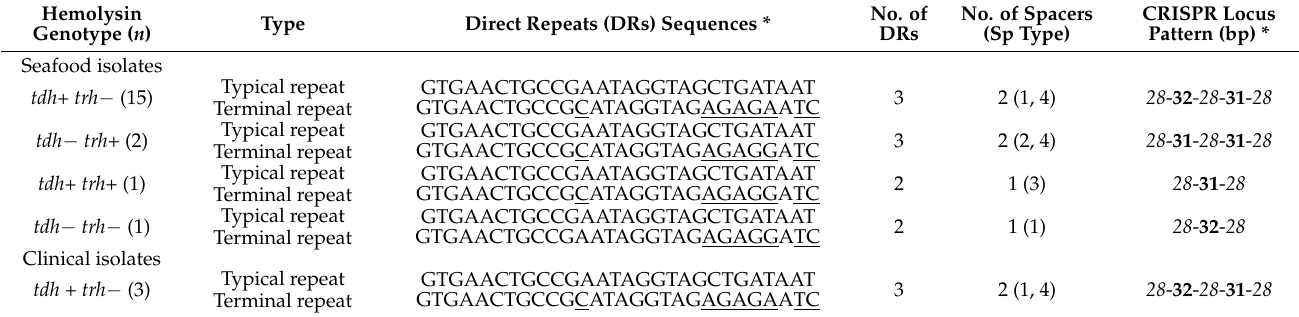
Table 3. Characteristics of CRISPR repeat sequences and pattern in CRISPR-positive V. parahaemolyticus isolates.